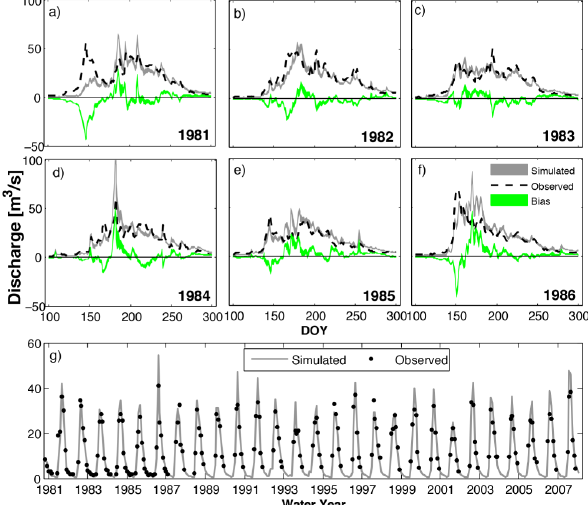
Fig. 6. (a–f) Simulated (gray) and observed (dashed black) melt season discharge and model bias for WY 1981–1986. The range of uncertainty from parameter selection is indicated by thickness of the plotted simulated and bias lines. (g) Simulated (gray, solid) and observed (circles) monthly mean streamflow for the entire period of analysis